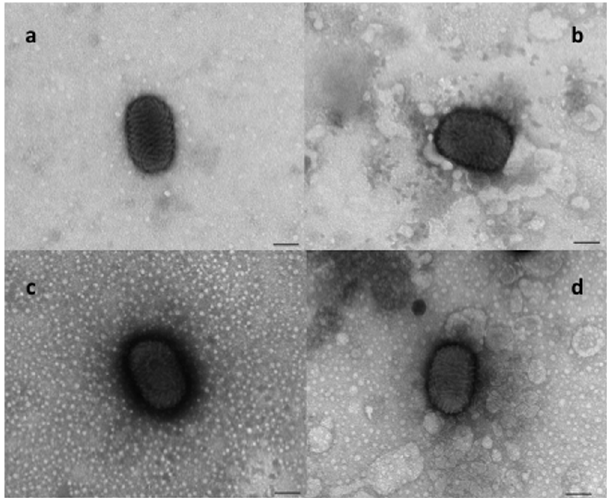
Fig 3. Electron microscopic analysis of cetacean poxviruses. Viral particles from tattoo lesions of a juvenile male striped common dolphin (c) and a juvenile female harbour porpoise (d). By their size and ovoid shape they resemble parapoxviruses, such as the sheep parapoxvirus displayed for comparison (a). Their surface morphology, however, more resembles a ball of string, typical of orthopoxviruses (b).